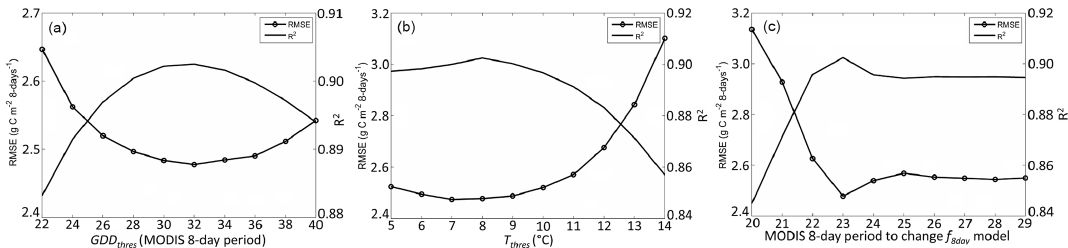
Figure 5. Influence on RMSE and R 2 of GDD thres (a) , T thres (b) , and the optimal period to change from the first to the second f 8day model (c) . RMSE is computed from mean of daily GPP over 8-day periods.